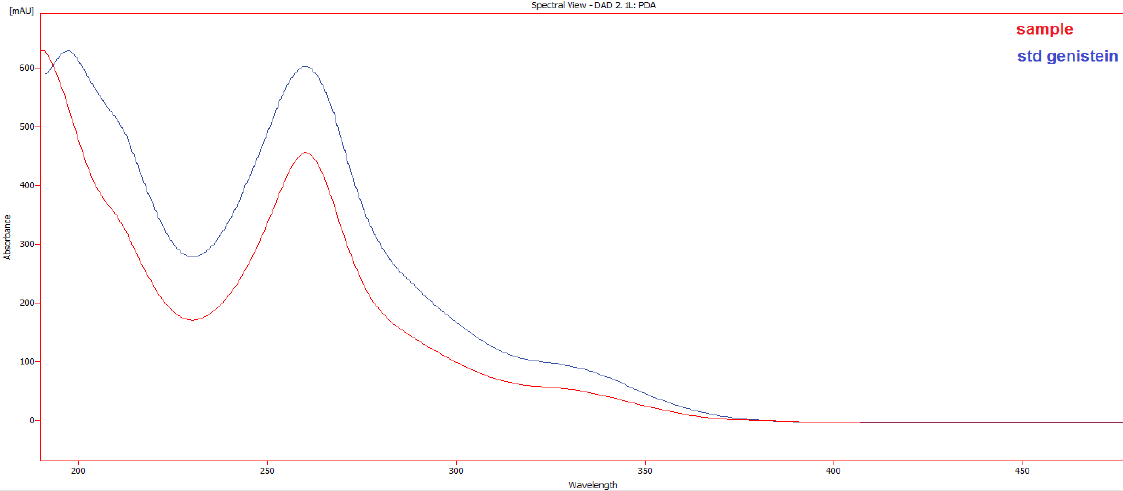
Figure 8. UV spectrum of fraction of ethyl acetate matched with genistein standard UV